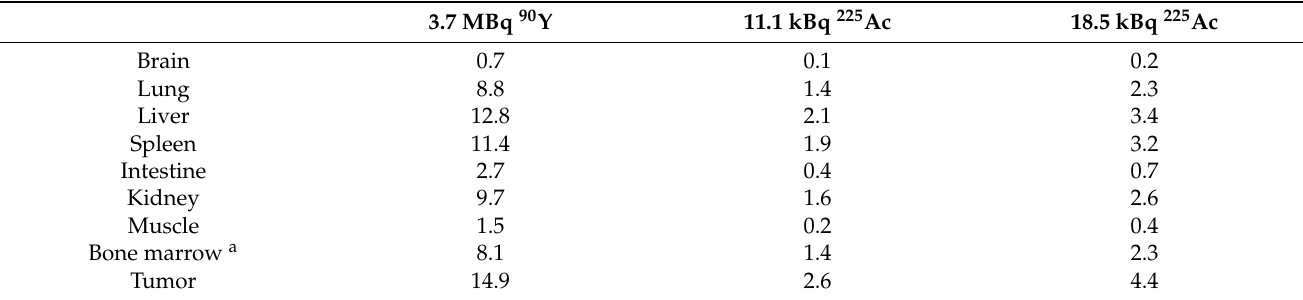
Table 4. Estimated absorbed doses (Gy) from the treatment dose of 90 Y- and 225 Ac-labeled NZ-16, not considering a radiation weighting factor.